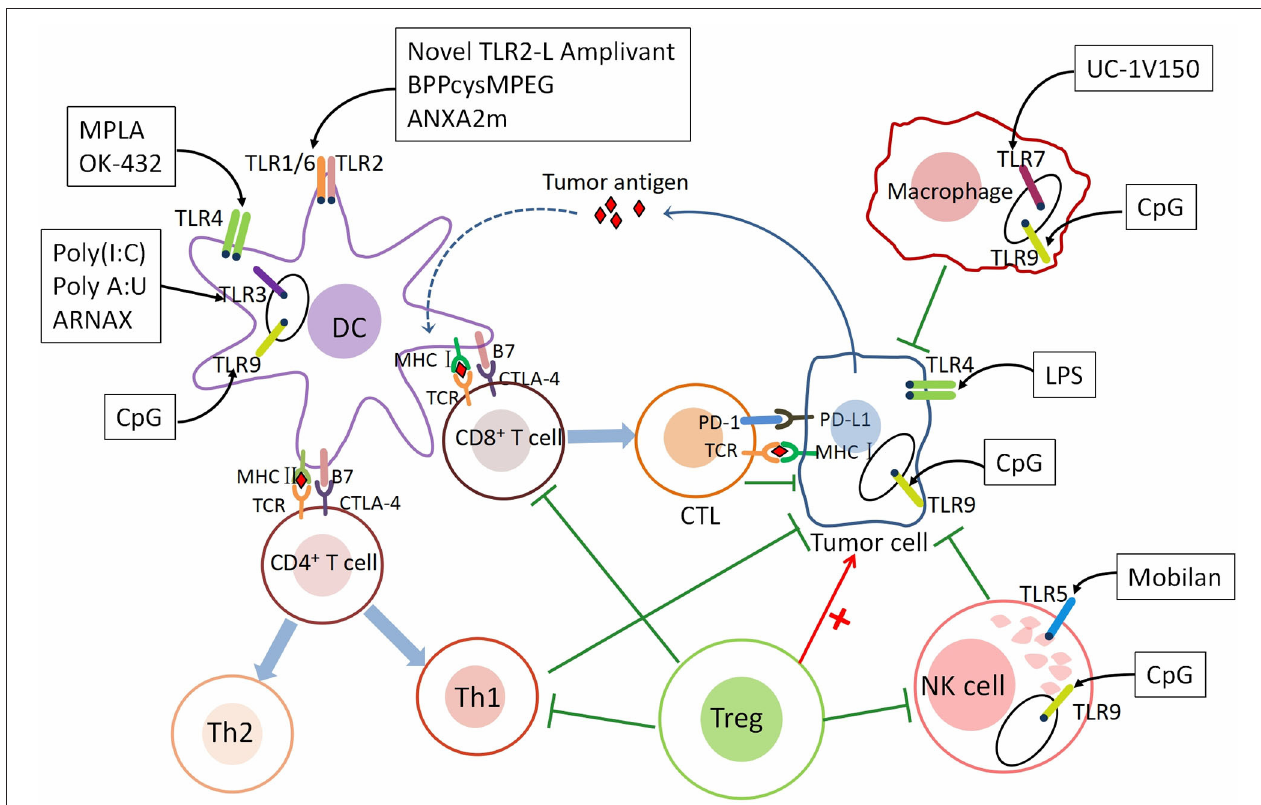
FIGURE 1 | The mechanism underlying the role of TLRs in tumor immunity. TLRs are expressed on different immune cells and cancer cells. The roles of immune cells in tumor immunity. As a class of antigen-presenting cells (APCs), dendritic cells (DCs) recognize tumor antigen and present the antigen to CD8 + T cells through the MHC class I pathway and CD4 + T cells through the MHC class II pathway. After activated by DCs, CD8 + T cells differentiate into cytotoxic T lymphocytes (CTLs) and CD4 + T cells differentiate into Th1 and Th2 cells. CTLs are recruited to the tumor microenvironment (TME) and recognize tumor cells through T cell receptor (TCR) and MHC class I-bound antigen, then kill them. Th1 cells secreting proinflammatory cytokines such as IL-2, TNF- α , and IFN- γ to promote immunity. Immune checkpoints—CTLA-4 and PD-1, can suppress T cell response. NK cells inhibit cancer by directly kill tumor cells and secreting several inflammatory factors. M1 macrophages are pro-inflammatory and M2 Macrophages are anti-inflammatory. Regulatory CD4 + T cells (Tregs) are anti-inflammatory cells suppressing of CTLs, Th1 cells, macrophages, and NK cells. TLRs are expressed both on immune cells and gastric cancer cells. Different TLRs agonists act on different immune and cancer cells to affect tumor immunity—pro-tumor or anti-tumor. Th1 cells, T helper type 1 cells; Th2 cells, T helper type 2 cells; IL-2, interleukin-2; TNF- α , tumor necrosis factor- α ; IFN- γ , interferon- γ ; CTLA-4, The cytotoxic T-lymphocyte-associated antigen-4; PD-1, Programmed cell death protein 1; PD-L1, Programmed death ligand